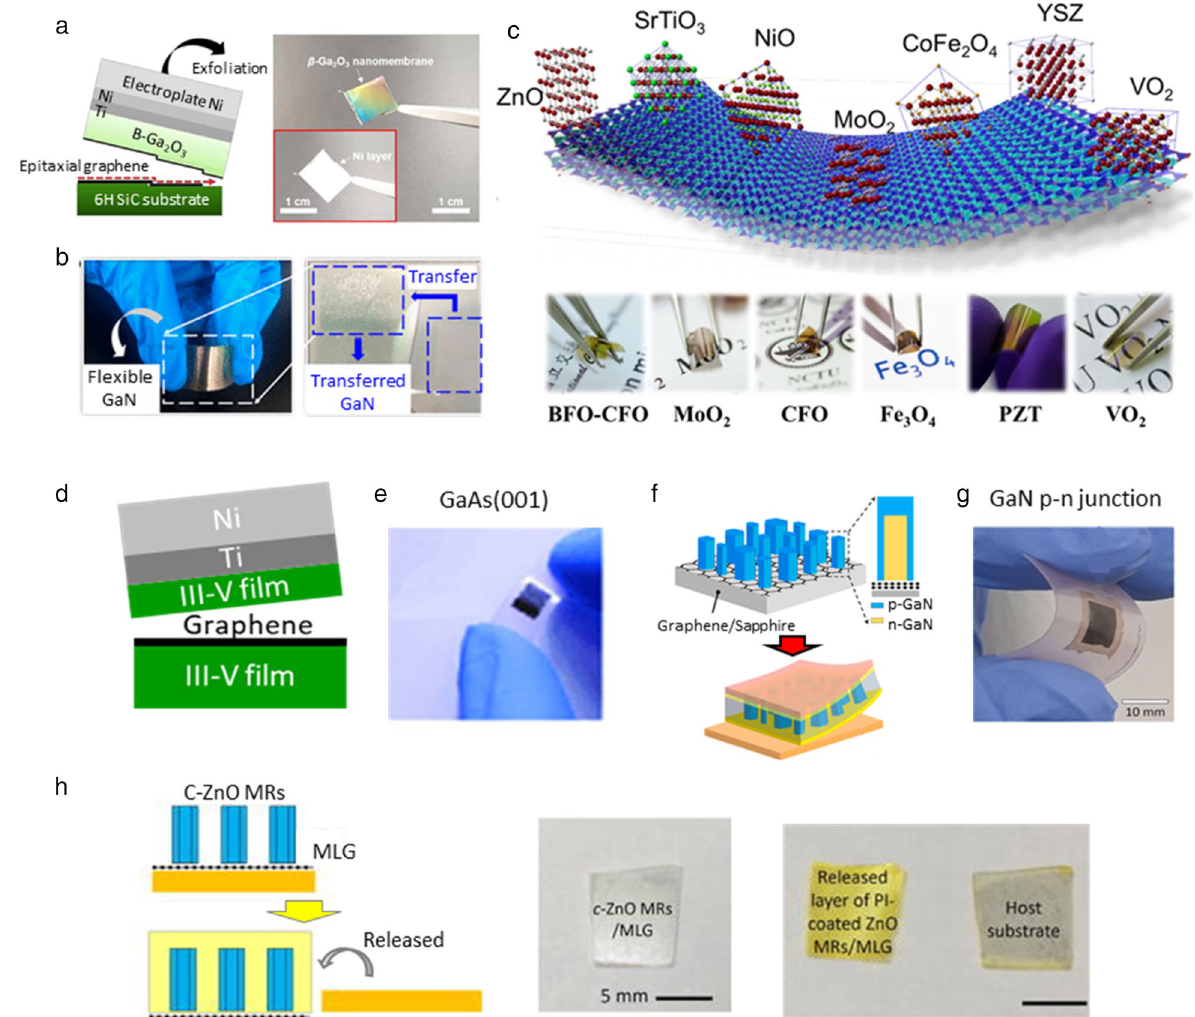
Fig. 1 a . Schematic illustration explaining the principle of the exfoliation of β‑Ga 2 O 3 from the graphene on SiC and photograph of the exfoliated β‑Ga 2 O 3 nanomembrane; the inset indicates a flip of 180° for the nanomembrane [34], b . Photograph image of flexible GaN film transferred from graphene/sapphire substrate [35], c . Schematic of various vdW oxide heteroepitaxy of ZnO, MoO 2 , CoFe 2 O 4 , Fe 3 O 4 , PbZrTiO 3 , VO 2 [22, 36–41], d . Schematic views of remote epitaxy of III‑V on graphene/III‑V substrate and exfoliation of grown III‑V layer, e . Photographs of single‑crystalline GaAs(001) exfoliated from graphene GaAs(001) substrate [42], f . Schematic illustration depicting fabrication procedures for flexible GaN‑LED array encapsulated with polyimide filler, g . Photograph of polyimide encapsulated GaN‑LED exfoliated from substrate [43], h . Schematics depicting the exfoliation of the heteroepitaxial ZnO microrods process using the thermal release tape technique, and corresponding result sample photographs of ZnO microrods coated by PI